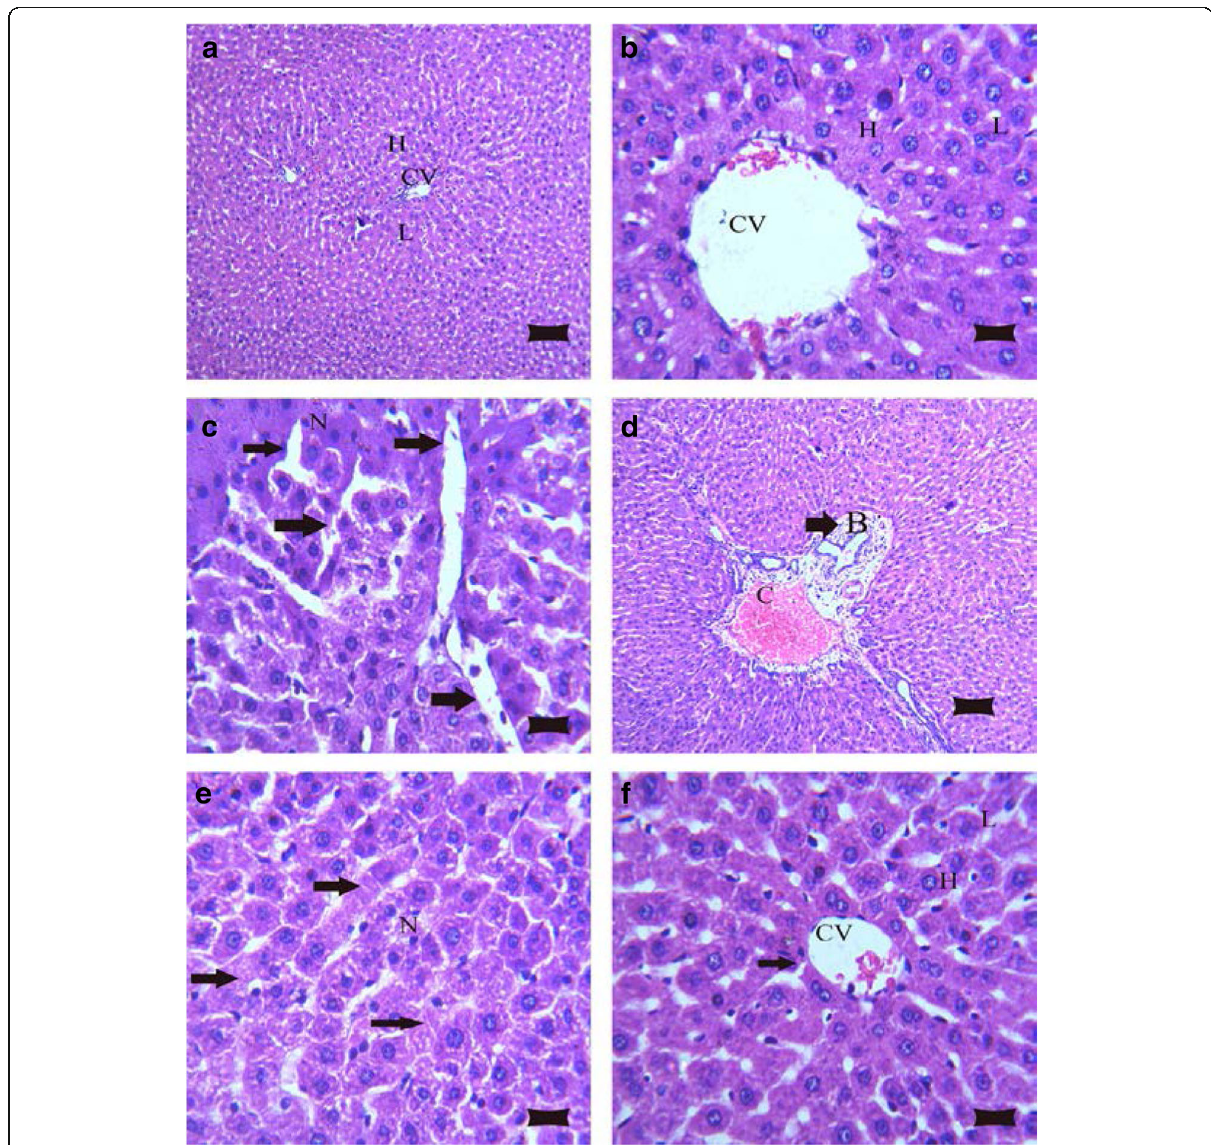
Fig. 1 Photomicrograph of rat livers in the various groups: a Control group, showing the normal histological structure of hepatic lobule ( L ) with centrally located euchromatic nucleus of hepatocyte ( H ) surround central vein ( CV ) (H&E; bar, 89 μ m); b Karela administered group, shows normal histological structure of hepatic lobule ( L ), hepatocyte ( H ) and central vein ( CV ) (H&E; bar, 14 μ m); c Cholesterol group, showing deposition of cholesterol crystals in many radicular cysts forming cholesterol clefts ( arrows ) and necrosis ( N ) of hepatocytes (H&E; bar, 14 μ m); d Cholesterol administered group, showing sever congestion of portal blood vessel ( C ) with extensive portal fibrosis ( arrow ) and hyperplasia of epithelial lining of the bile duct ( B ) (H&E; bar, 89 μ m); e Cholesterol group, showing necrosis in hepatocytes ( N ) with karyolysis of hepatocytes nuclei ( arrows ) (H&E; bar, 14 μ m); and f Cholesterol and Karela group, show apparent normal hepatic parenchyma with few cholesterol clefts ( arrow ), hepatic lobule ( L ), hepatocyte ( H ), central vein ( CV ) (H&E; bar, 14 μ